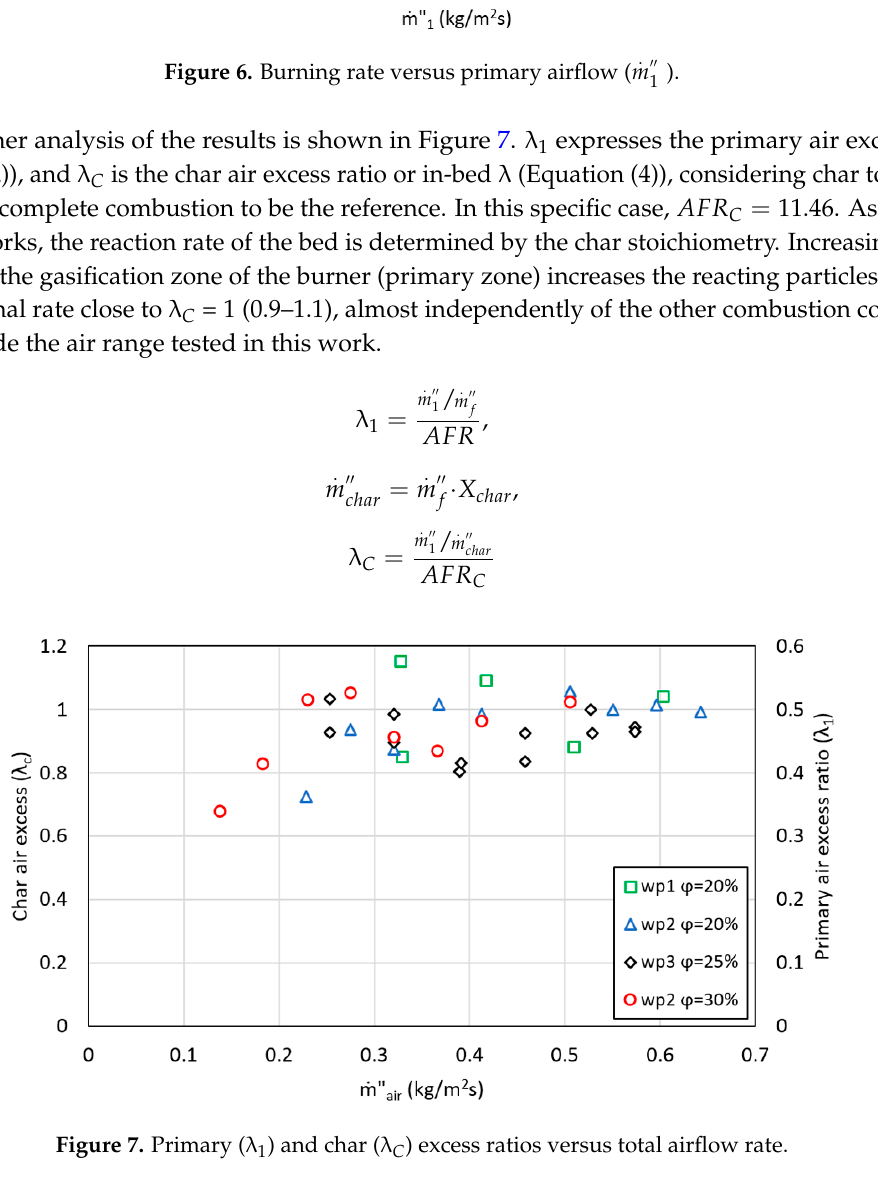
Figure 6. Burning rate versus primary airflow ( (cid:1865)(cid:4662) (cid:2869)(cid:4593)(cid:4593) ).